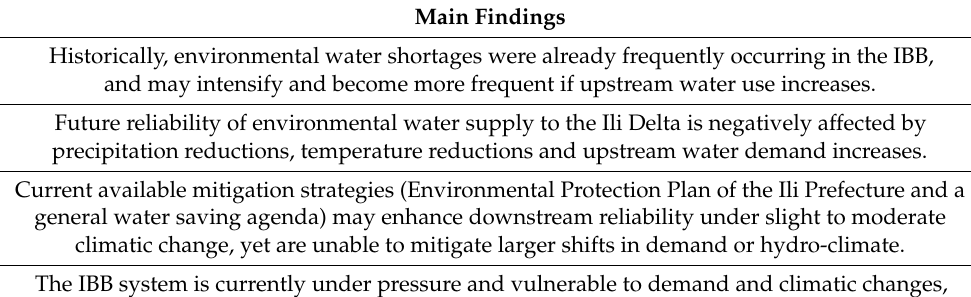
Table 4. Summary of main